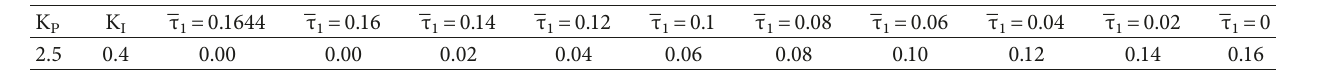
− 5, the highest acceptable delay bound τ ̅ 1